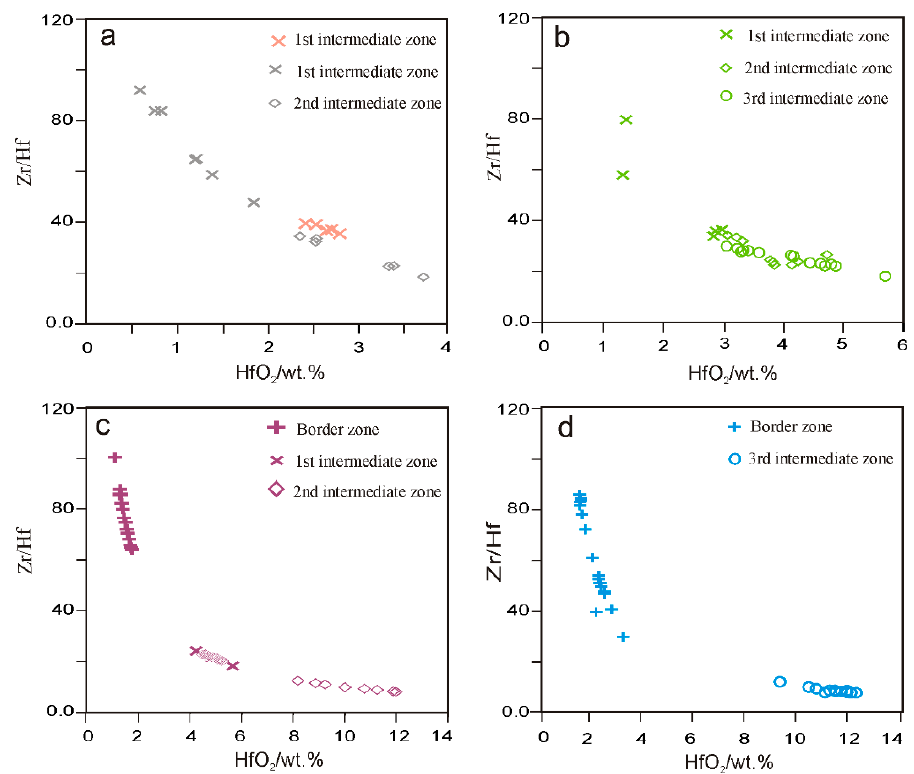
Figure 16. Zr/Hf vs HfO 2 in the Giraúl pegmatites ( a ) type I, orange, and II, grey, ( b ) type III, ( c ) type Figure 16. Zr / Hf vs HfO 2 in the Gira ú l pegmatites ( a ) type I, orange, and II, grey, ( b ) type III, ( c ) type IV, ( d ) type V. IV, ( d ) type